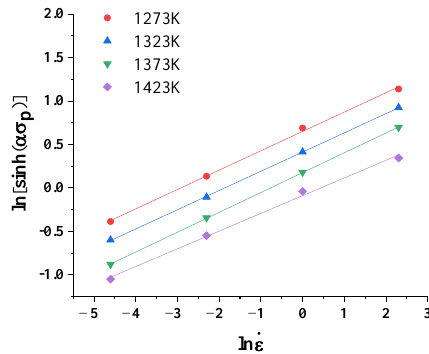
. ε Figure 4. Relationship between ln and ln[sinh( ασ p )] at di ff erent temperatures. Figure 4. Relationship between and ln[sinh( αp )] at different temperatures.